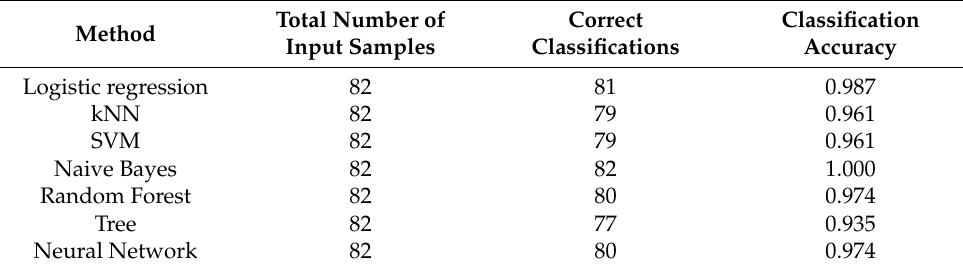
Table 1. Methods comparison with their classification